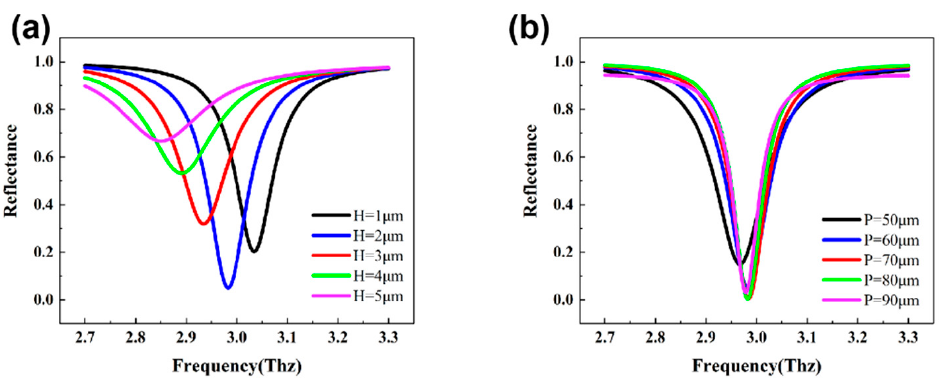
Figure 3. ( a ) The effect of absorber medium layer thickness on structure reflectivity. ( b ) The effect of the period on structure reflectivity.